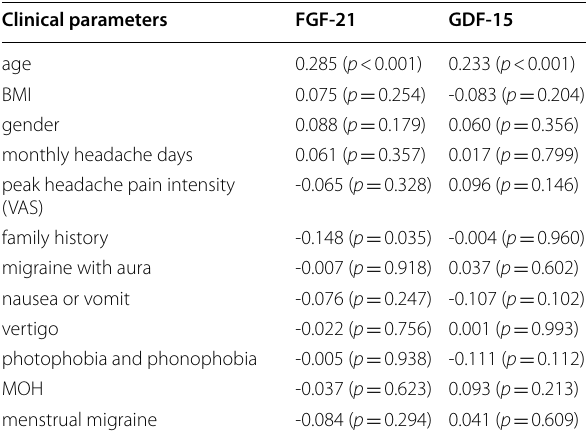
Table 3 Clinical parameters of headache and their impact on FGF-21 and GDF-15 levels in migraineurs. Partial correlation analysis was used for analysis. The results are given as r values ( p values). The results are given as p